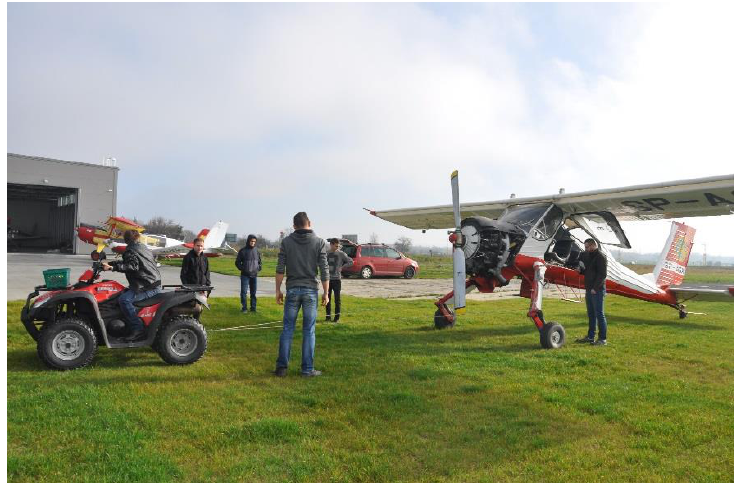
Figure 8. Starting a test run. The test airplane is pulled by an all-terrain vehicle (ATV). The test engineer is walking by the test airplane, collecting data wirelessly. Four persons onboard the airplane.